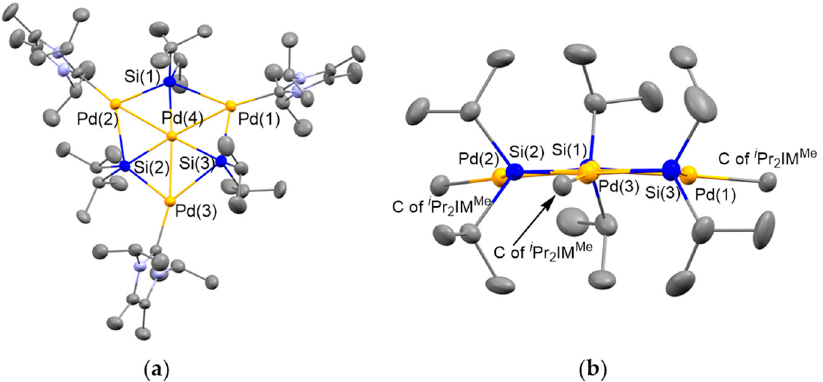
Figure 2. ( a ) Top view of the molecular structure of 5 with 50% probability ellipsoids. Hydrogen atoms were omitted for clarity; ( b ) Side view of 5 . All atoms derived from the i Pr 2 IMMe ligands except for the coordinated carbon atoms, and all hydrogen atoms were omitted for clarity.